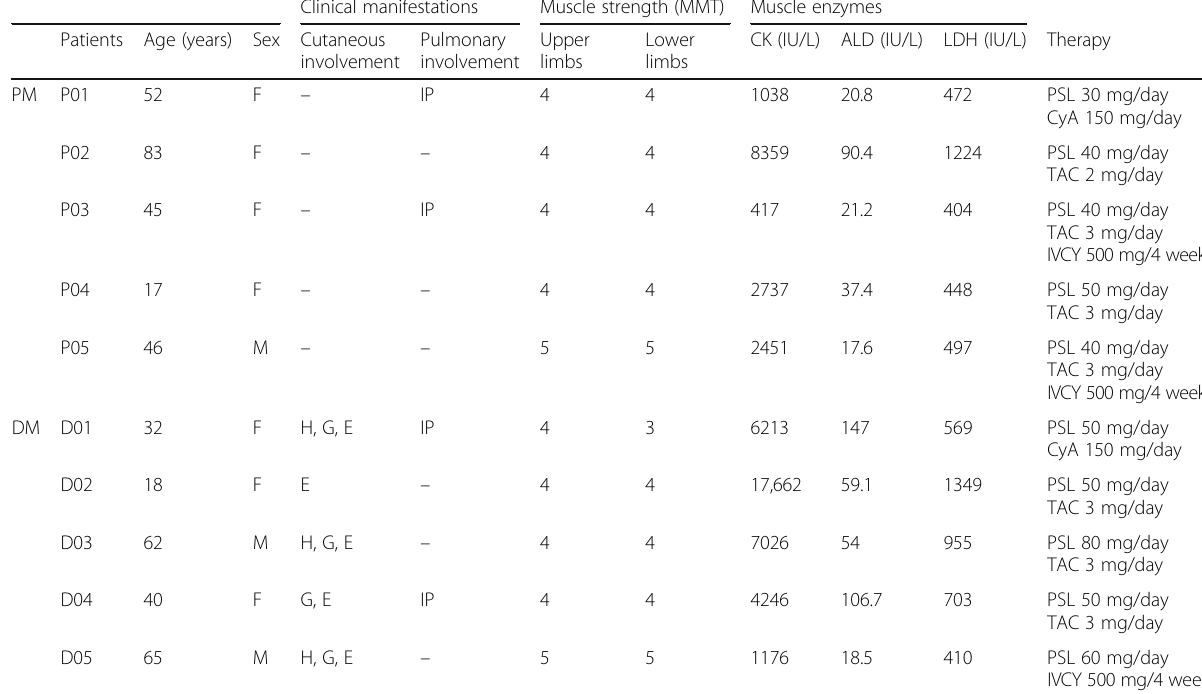
Table 1 Clinicopathological characteristics of PM/DM patients Clinical manifestations Muscle strength (MMT) Muscle